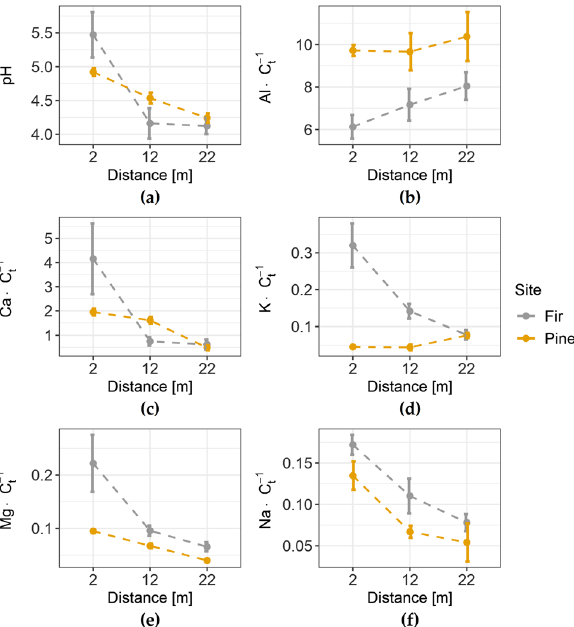
Figure 4. The soil pH ( a ) and stoichiometric ratios to total carbon (C t ) of exchangeable aluminum (Al 3+ ) ( b ), exchangeable base cations (Ca 2+ , K + , Mg 2+ , Na + ) ( c – f , respectively), plotted against the distance from the forest edge. The circle represents the mean; the whiskers indicate the standard